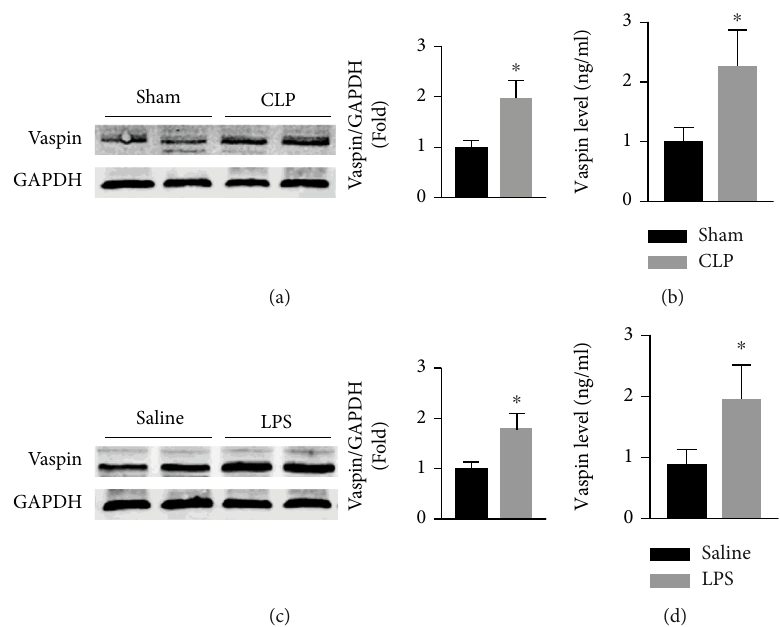
Figure 2: E ff ects of sepsis on vaspin expression in mice. Cardiac (a) and serum (b). Vaspin expression in sham and CLP mice (Student ’ s t test). Cardiac (c) and serum (d). Vaspin levels in saline- and LPS-treated mice (Student ’ s t test). N = 6 in each group. ∗ p < 0 : 05 vs. the sham or saline